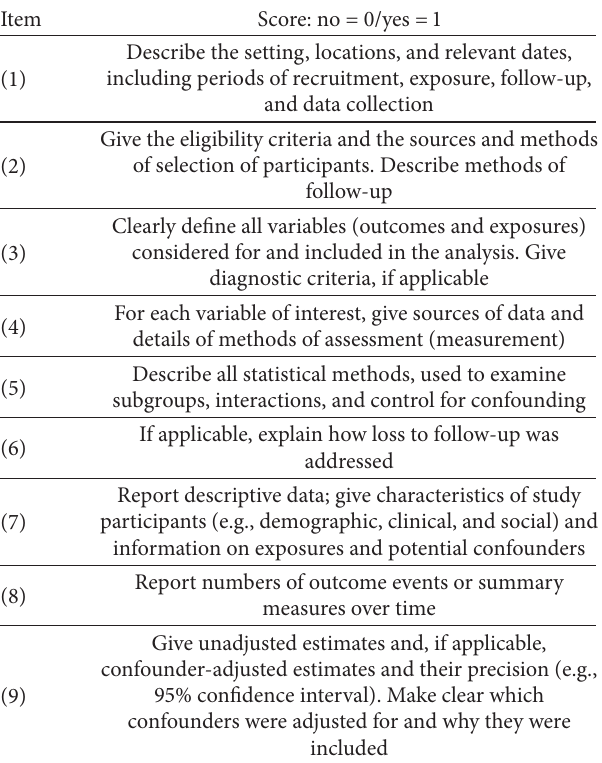
Table 2: Standard checklist for assessment of methodological quality of prospective cohort